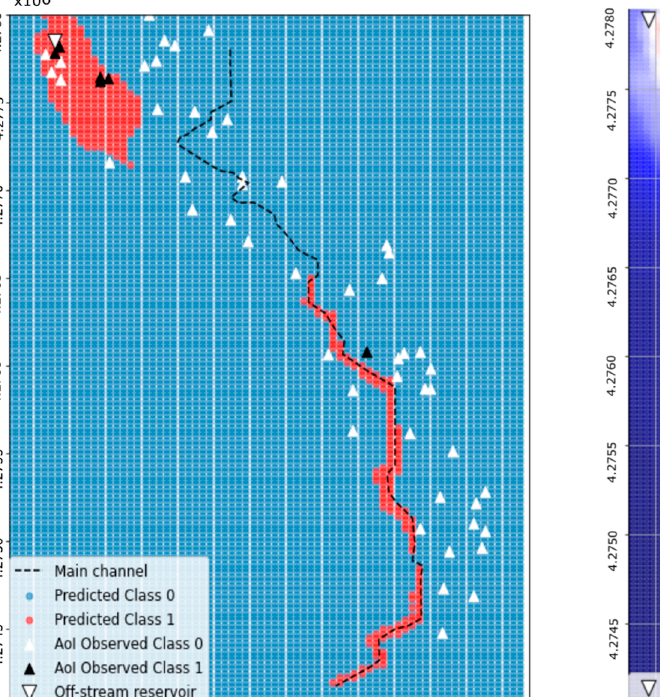
Figure 19. Cross-section at the location of the FN (section 34).